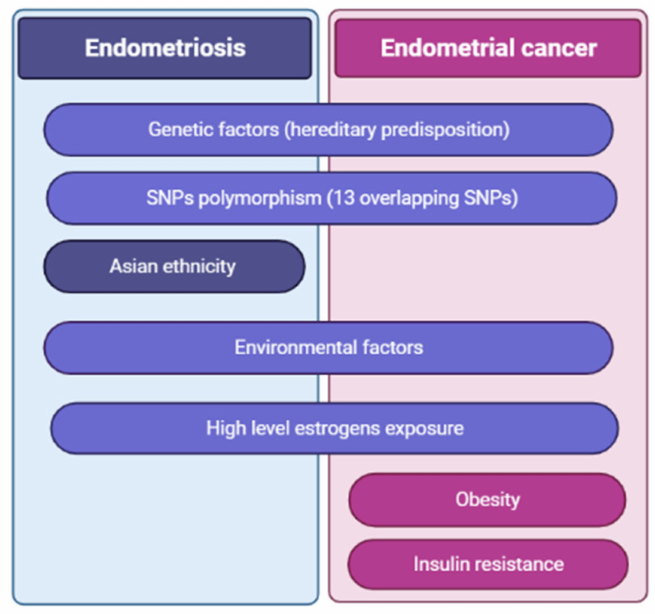
Figure 1. Risk factors for endometriosis and endometrial cancer. Created at BioRender.com (accessed on 15 July